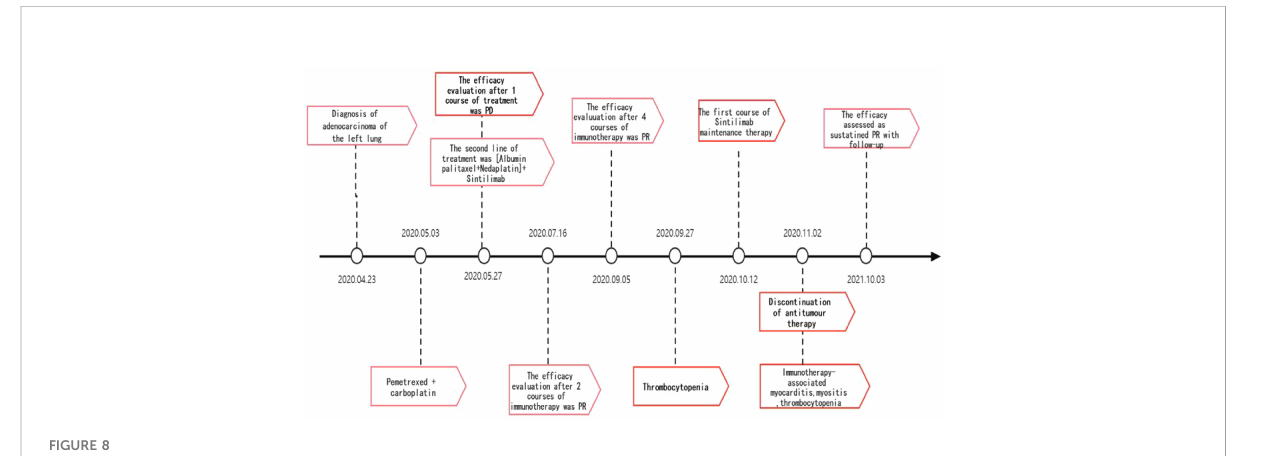
FIGURE 8 A summary of a clinical course.